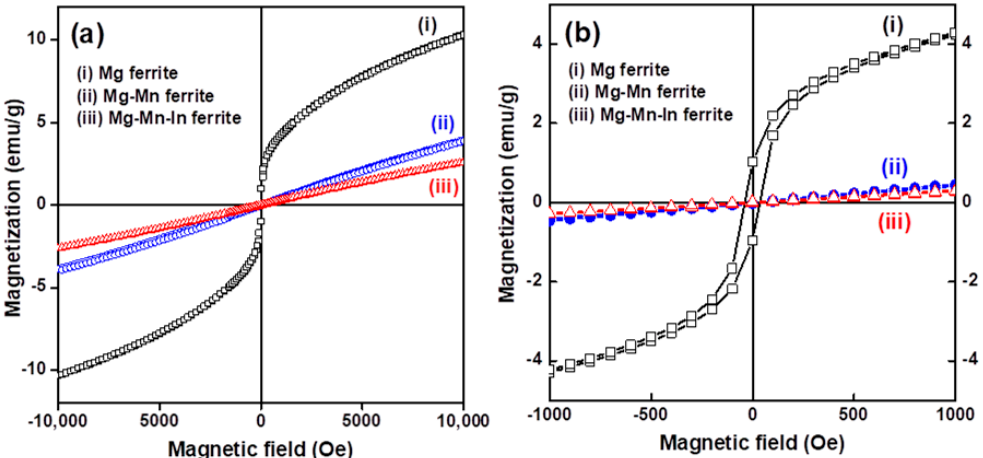
Figure 4. ( a ) Magnetization versus applied magnetic field for Mg, Mg-Mn, and Mg-Mn-In nanoferrites; ( b ) the magnetization (M-H) curves of the corresponding Mg-based spinel ferrite nanoparticles in the low magnetic field region (±1000 Oe).